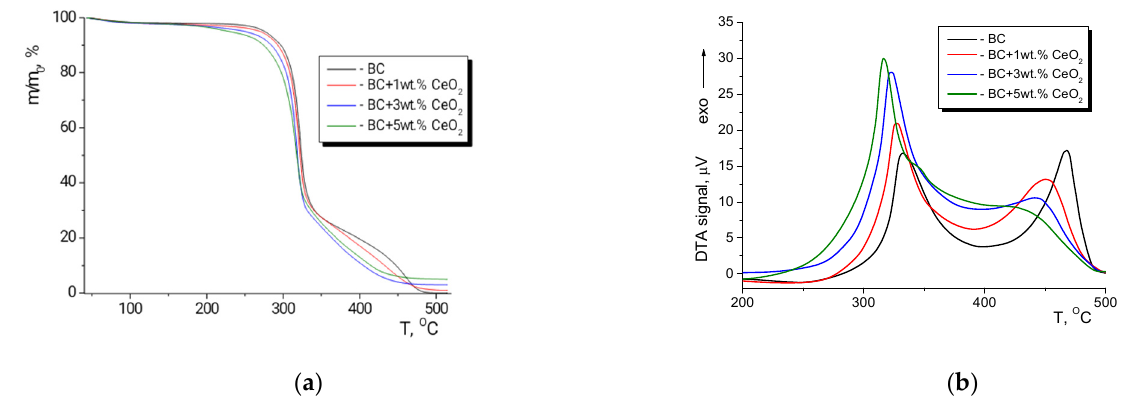
Figure 4. ( a ) TGA and ( b ) DTA curves of bare BC film and nanocomposite films containing different amounts of ceria. Table 1. Thermal stability indices of the BC and BC-ceria nanocomposite films.